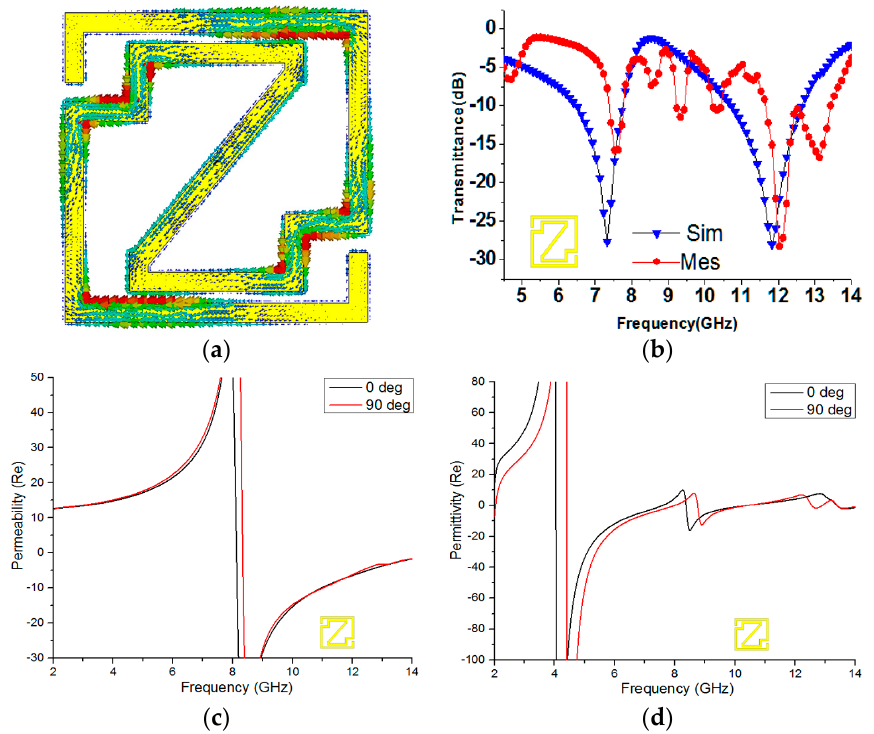
Figure 5. ( a ) Surface current density at 11.84 GHz; ( b ) S 21 curve for the Z-shape unit cell; the real magnitude of ( c ) the effective permeability and ( d ) the effective permittivity of a 0-degree and 90-degree rotated unit cell.